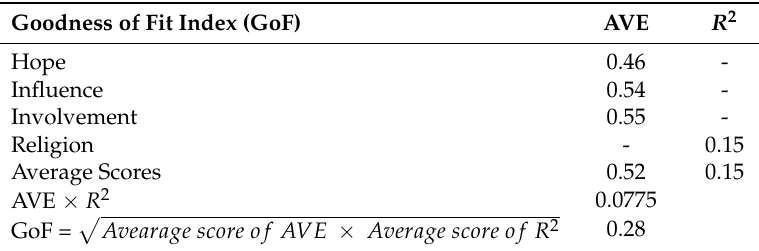
Table 5. Goodness of Fit index (GoF).